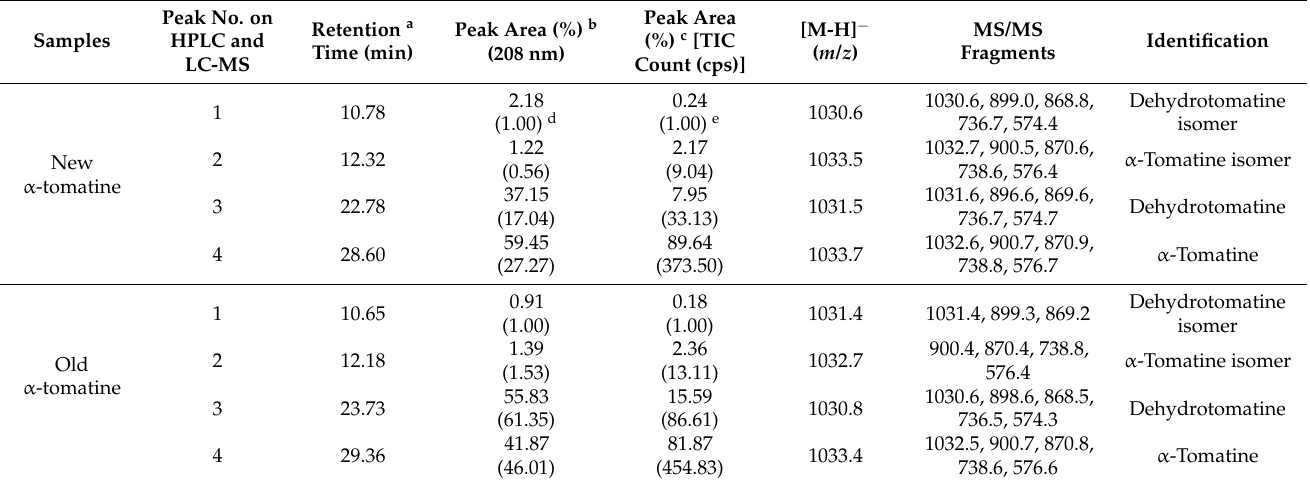
Table 4. Retention times, peak areas, MS, and MS/MS by LC-MS of tomatine samples B and C (column packing, 3 µ m particle